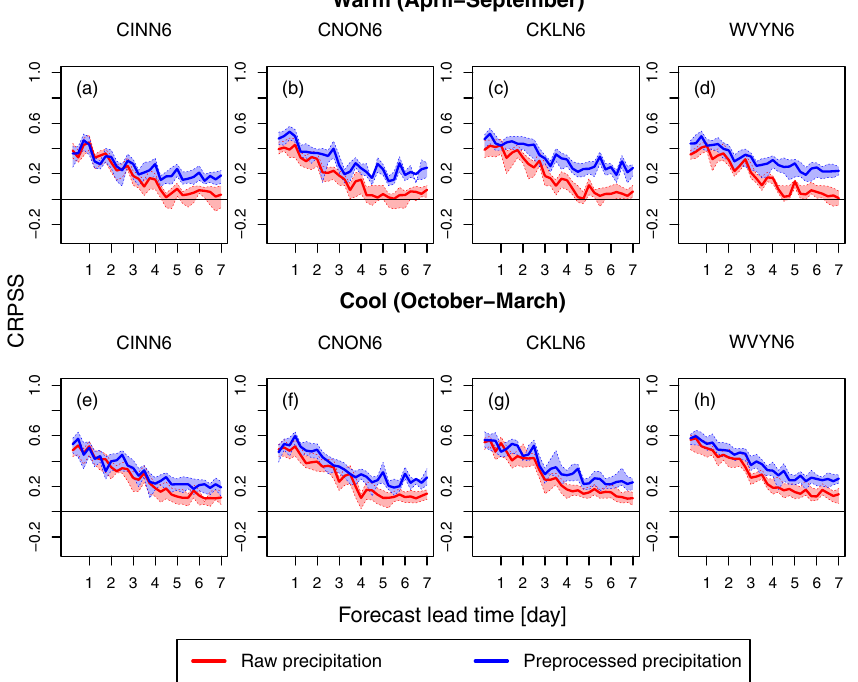
Figure 3. CRPSS (relative to sampled climatology) of the raw (red curves) and preprocessed (blue curves) ensemble precipitation forecasts from the GEFSRv2 vs. the forecast lead time during the (a) – (d) warm (April–September) and (e) – (h) cool season (October–March) for the selected